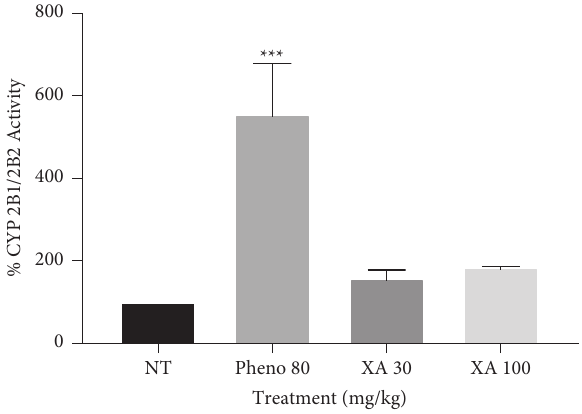
Figure 6: Effect of phenobarbitone (Pheno 80), xylopic acid low dose (30 mg/kg; XA 30), and xylopic acid high dose (100mg/kg; XA 100) on CYP 2C9 (diclofenac hydroxylation). Data are presented as mean ± S.E.M ∗∗∗ P < 0 . 001 compared to the no-treatment group (one-way ANOVA followed by Tukey’s post hoc test).